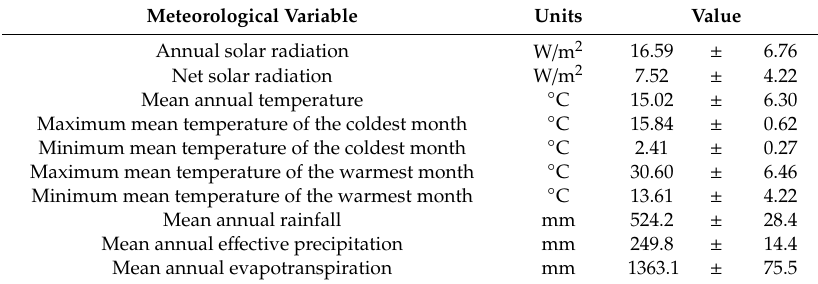
Table A1. Means ± SD of meteorological parameters calculated for the period 01 / 01 / 2013 to 31 / 12 / 2018. From: Redarex; Meteorological station: Valdesalor (CC18) which, is approximately 31 km away from the study area; altitude: 382 m.; coordinates UTM H30 X: 730,101, Y: 4,361,000; Extracted from [62].